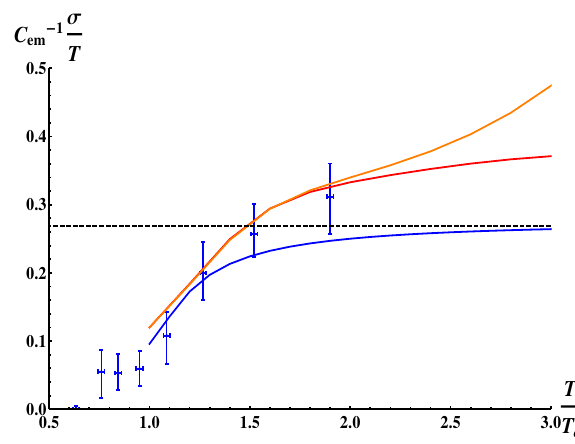
Figure 1 . The orange, red, and blue (from top to bottom) curves correspond to VQCD2, VQCD1, and GN model, respectively. The black dashed line represents the result for the SYM plasma and the blue dots correspond to the lattice simulation with three (cid:13)avors [9], where C em = 2 e 2 = 3 and we take N c = N f =